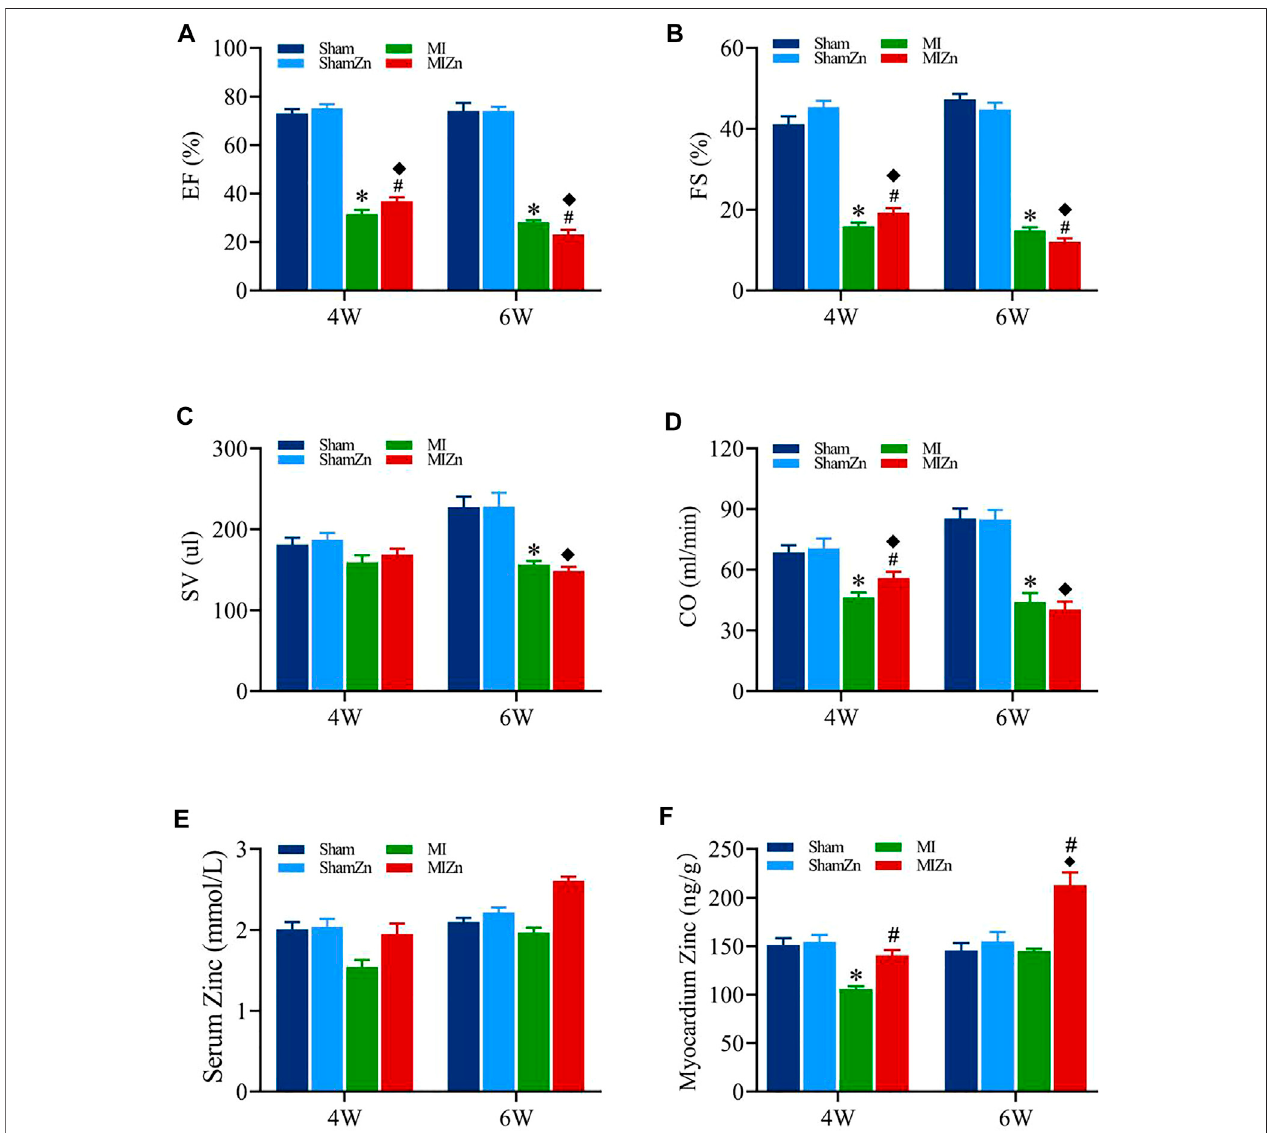
FIGURE 1 | Cardiac functions and zinc levels in eight groups. Panels (A – D) show the change of EF, FS, SV, CO, respectively. Panels (E,F) show the change of serum and myocardium zinc concentrations, respectively. All of the data were shown as Mean ± SEM. * p < 0.05, MI vs. Sham; ◆ p < 0.05, ShamZn vs. MIZn; # p < 0.05, MIZn vs.